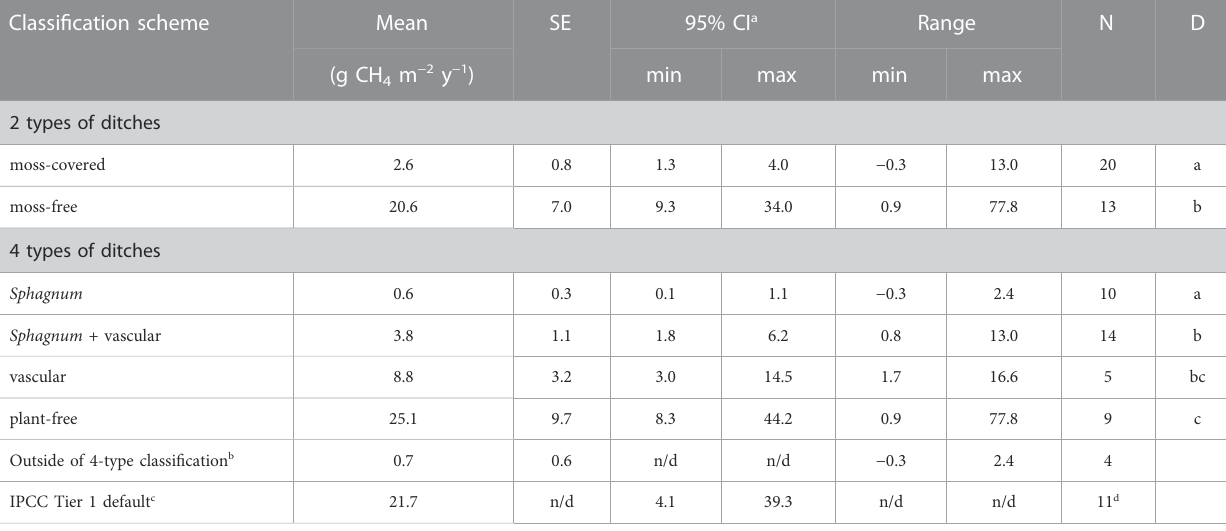
TABLE 3 CH 4 emission factors [mean, standard error (SE), 95% con fi dence interval (CI), range and number of replicates (N)] for different types of ditches of boreal forestry-drainedpeatlandsinFinland.DifferentlettersinDcolumnshowstatisticaldifferencesbetweenditchtypesinthe2-type( t -test,t(31)= − 4.0336, p < 0.001) and4-type classi fi cation schemes(1-ANOVA,F(3,33) =10.53, p < 0.001; Pairwise t -test withHolm-Bonferroniadjustmentof the p -value, p < 0.05),which werealso furthercon fi rmedbycomparisonof95%CIs(i.e.,non-overlapping95%CIsindicatesigni fi cantdifference).TheTier1CH 4 emissionfactor(mean,95%CIandN)for ditches of drained forest land and drained wetland of temperate and boreal area is shown for comparison.